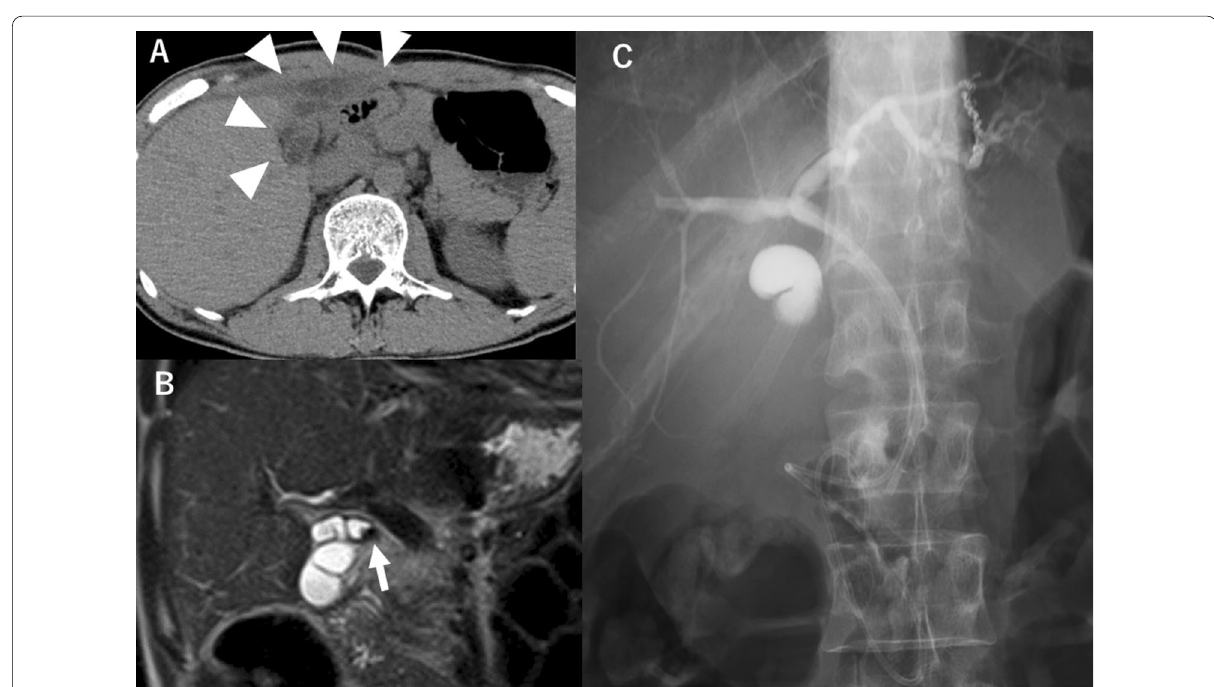
29 28 mm) with intraabdominal abscess under the × ×